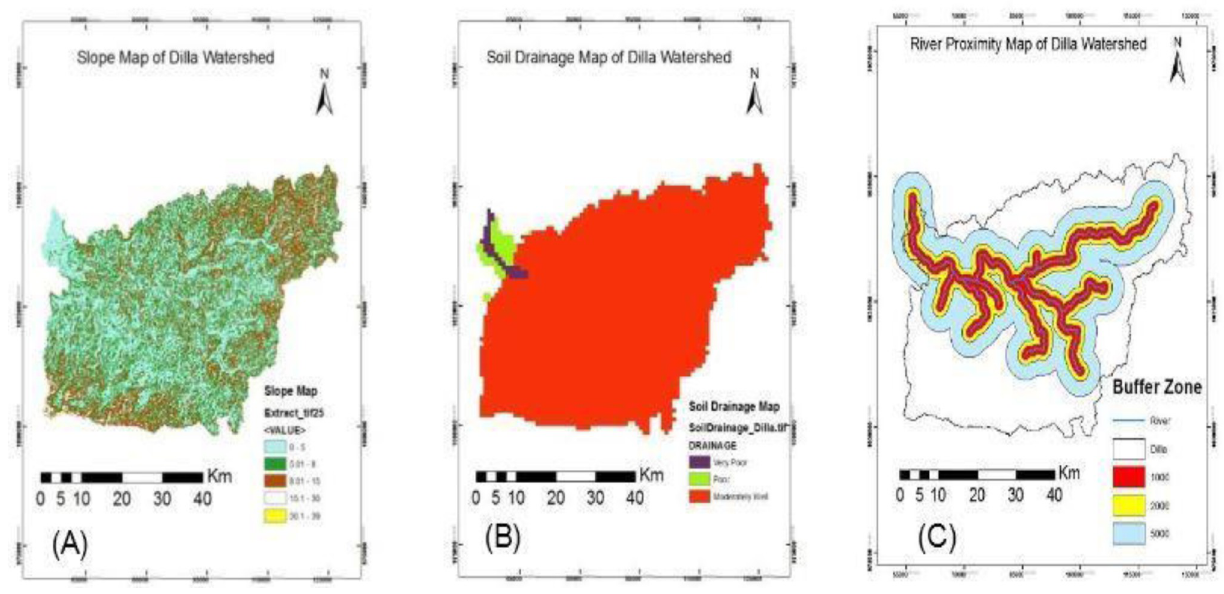
Fig 4. Slope, soil drainage, and river proximity based malaria risk area of Dilla watershed. Source: Ethiopian Central Statistical Agency.